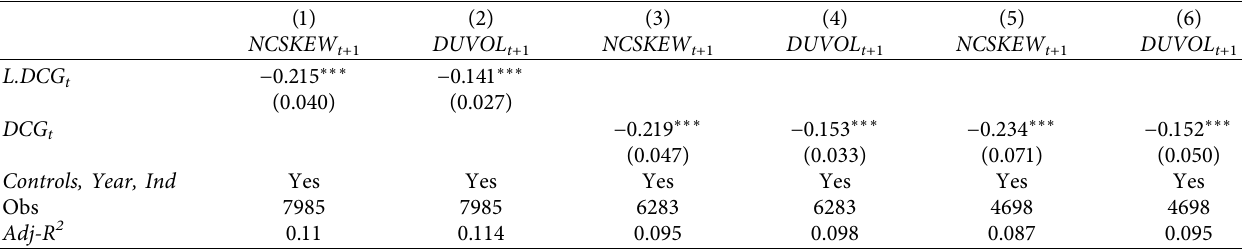
Table 9: Robustness test: longer forecast windows.